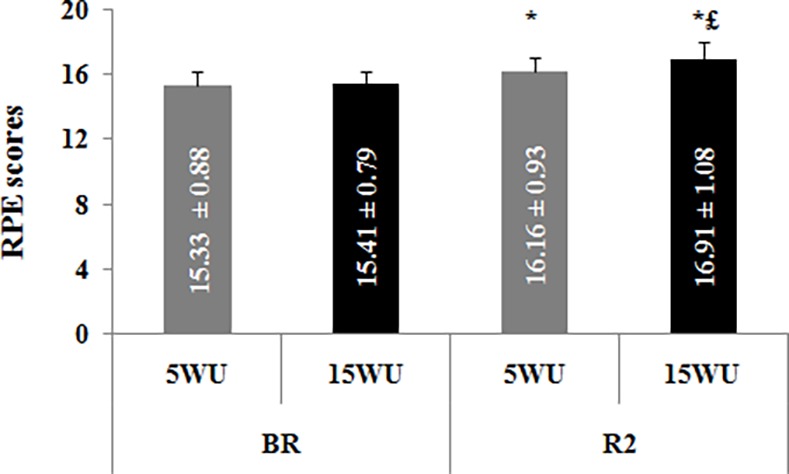
RPE scores (mean ± SD, n = 12) obtained following the 30-second Wingate test, after the 5-minute (5WU) and the 15-minute (15WU) warm-up, before (BR) and during (R2) Ramadan.*: significant difference in comparison with BR. £: significant difference in comparison with the 5-minute warm-up.